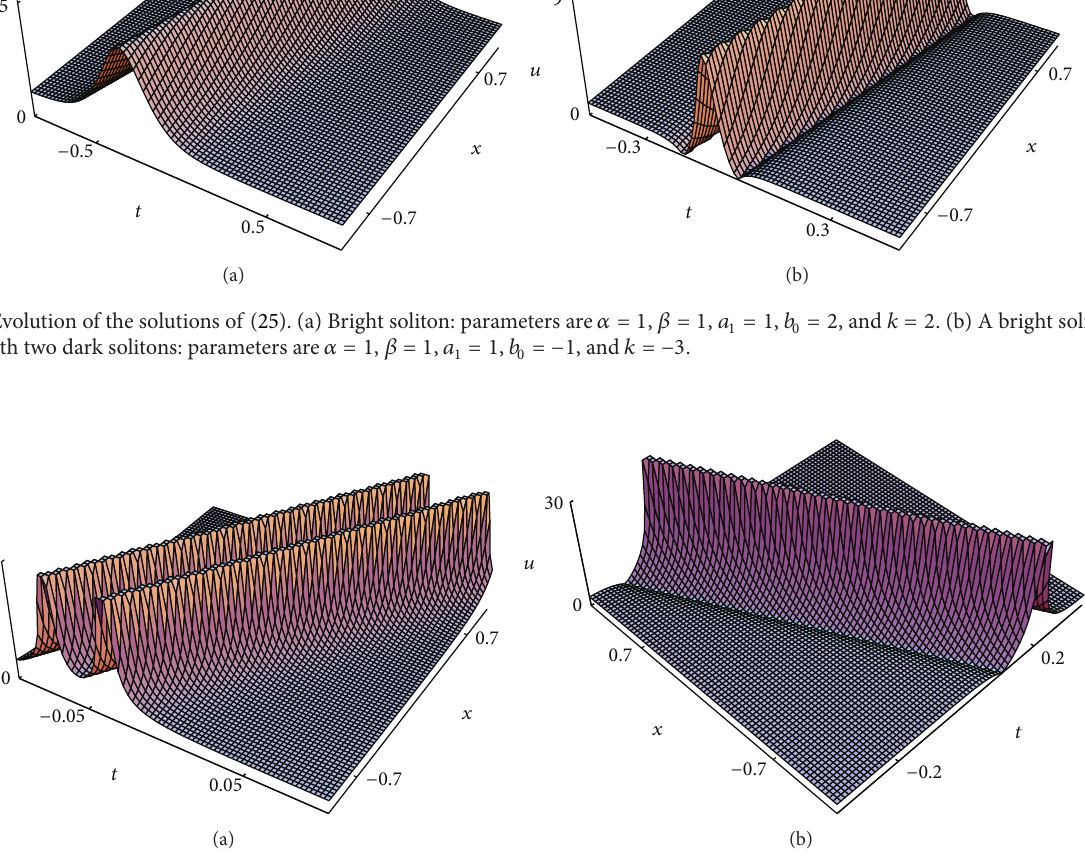
Figure 3: Evolution of the solutions of (25). (a) Two-peak bright soliton: parameters are 𝛼 = 1 , 𝛽 = −1 , 𝑎 1 = −5 , 𝑏 0 = −2 , and 𝑘 = 3 . (b) A bright soliton in collision with a dark soliton: parameters are 𝛼 = 1 , 𝛽 = −1 , 𝑎 1 = 3 , 𝑏 0 = −1 , and 𝑘 = 4 .